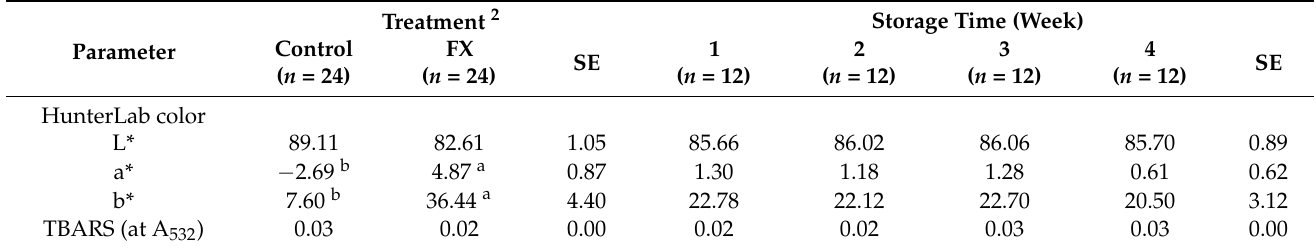
Table 5. Effect of fucoxanthin supplementation on color and lipid oxidation 1 of goat whole milk during storage (4 ◦ C). Treatment 2 Parameter